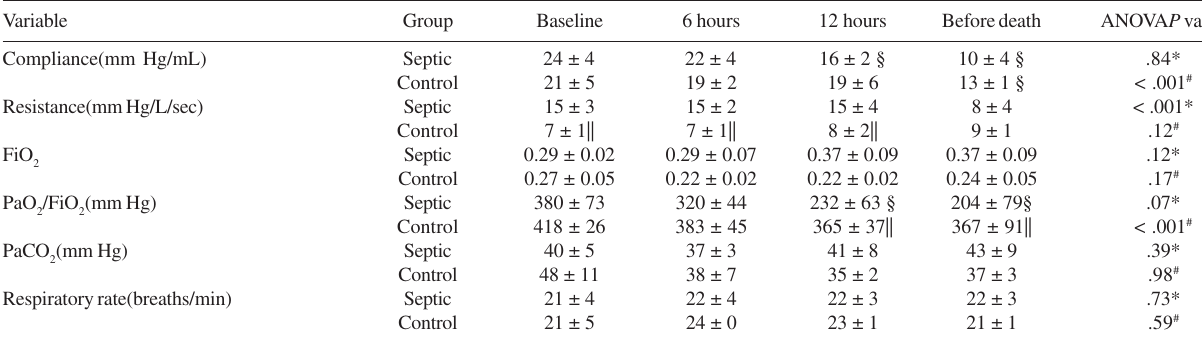
Table 2 - Evolution of respiratory parameters in septic and control groups Variable Group Baseline